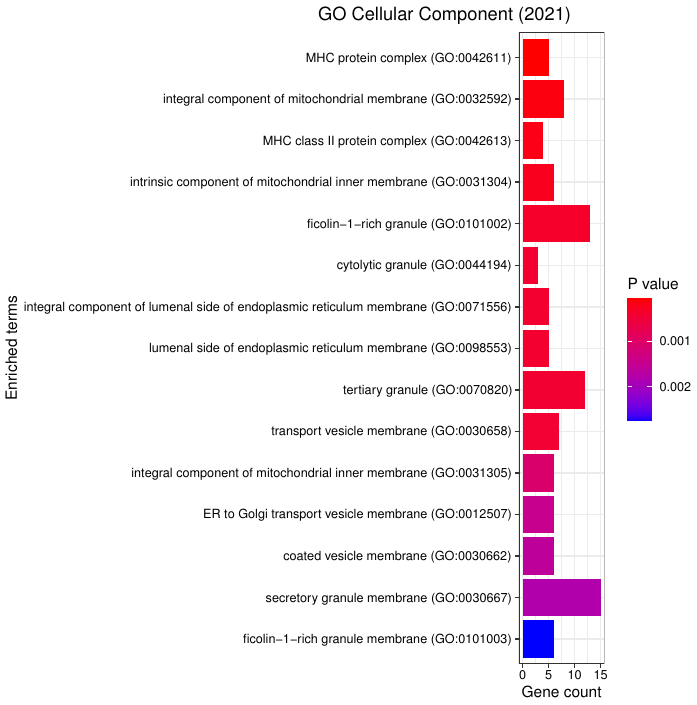
Figure 6. List of all the GO Cellular Components that are enriched in the selected genes with the respective number of genes belonging to each term. The analysis was performed with enrichR at an FDR < 0.05.